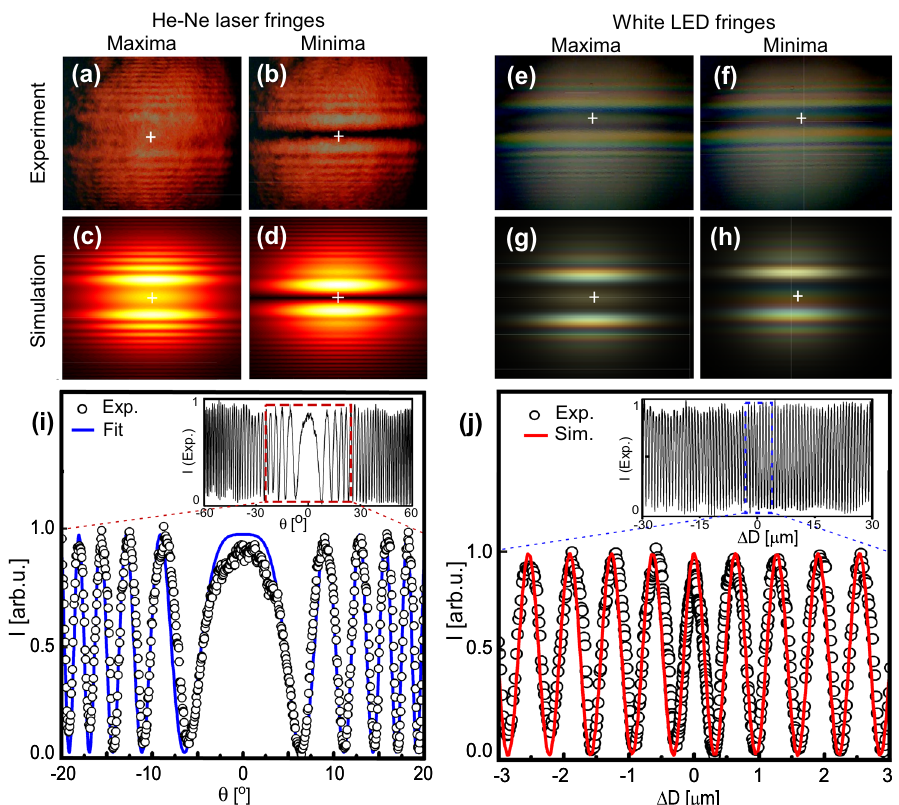
Figure 3. ( a )–( d ) Comparison of experimental and simulated interference fringes for a He–Ne laser, and ( e )–( h ) for white LED. The central maximum and minimum correspond to bright and dark central fringe. ( i ) Experimental intensity at cross-hair position along with a theoretical fit (Eq. 5) with I 0 =1. Inset: experimental He–Ne laser intensity for larger angular range from − 60 ◦ to 60 ◦ . (j) Simulated intensity and experimental intensity corresponding to (i) when calibrated in terms of optical path delay from -3 µ m to 3 µ m range. Inset: He–Ne laser intensity over a larger delay range from − 30 µ m to 30 µ m